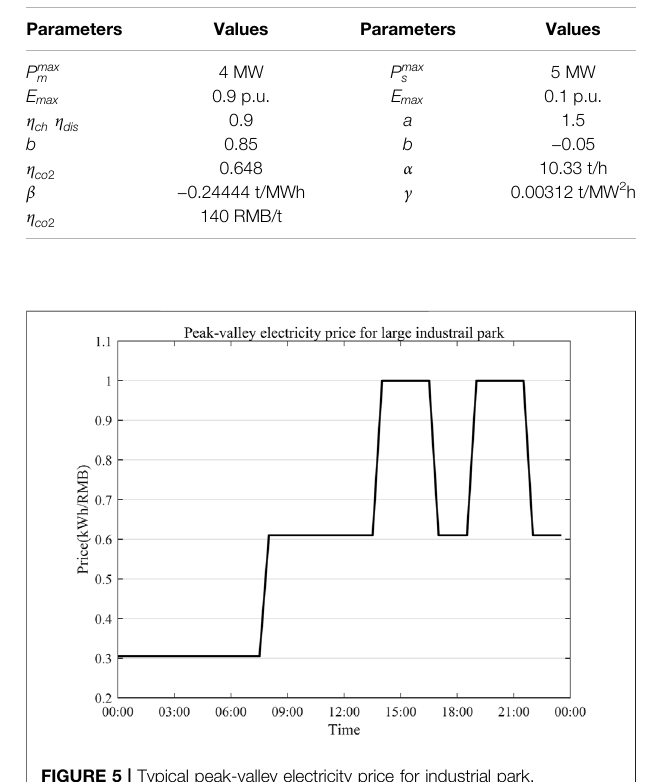
FIGURE 5 | Typical peak-valley electricity price for industrial park.